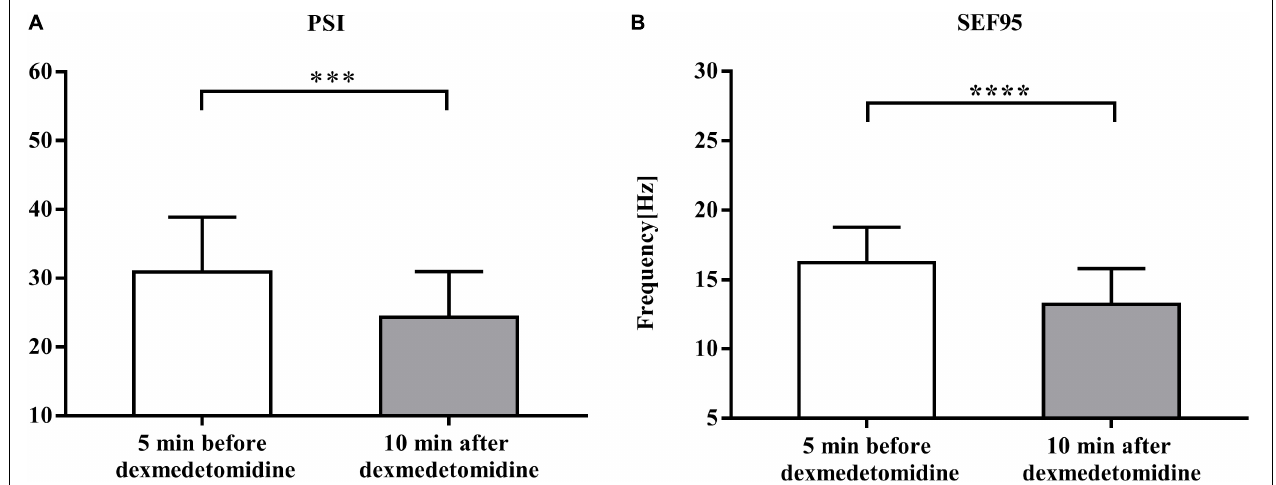
FIGURE 3 | Comparison of EEG monitoring data 5 min before and 10 min after dexmedetomidine infusion. (A) Comparison of values of patient status index (PSI) data 5 min before and 10 min after dexmedetomidine infusion under sevoflurane anesthesia. Data are given as mean ± SD (Paired t- test probability is indicated as: ∗∗∗ P < 0.001; **** P < 0.0001, n = 23). (B) Comparison of values of spectral edge frequency 95 (SEF95) data. Details as in (A) .